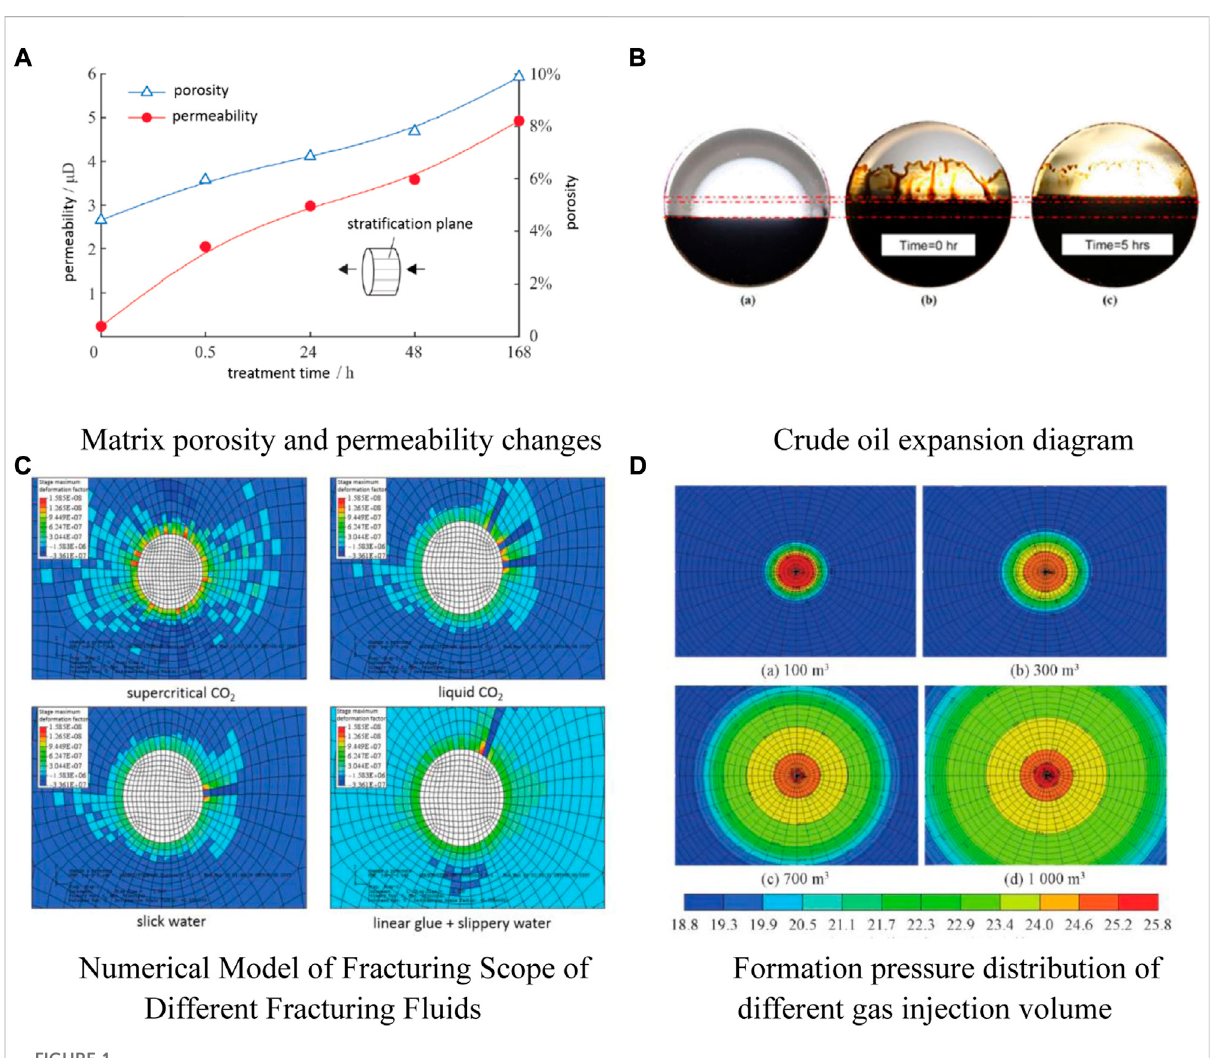
FIGURE 1 Effect of CO 2